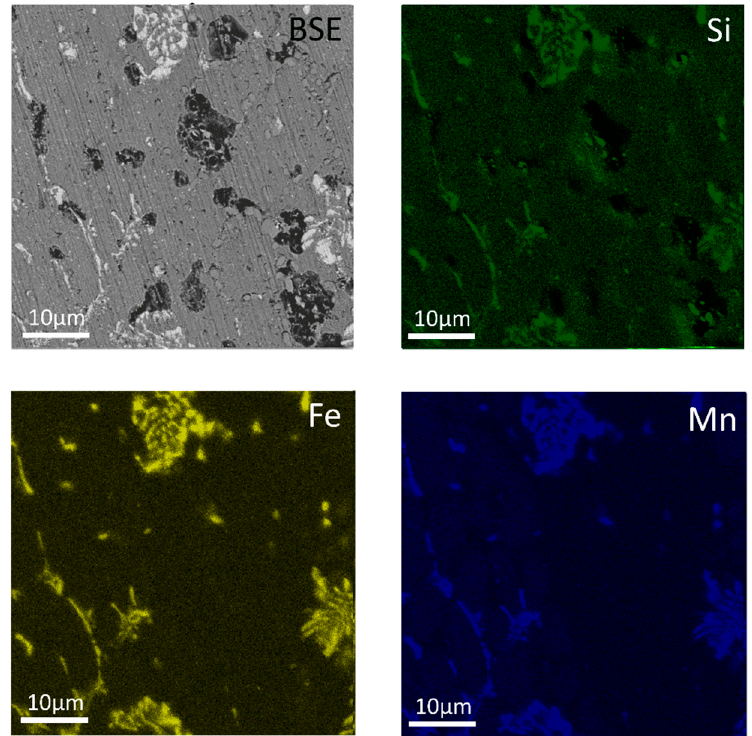
Figure 3. SEM image showing the dissolution of silicon particles and growth of voids (darker areas in the BSE image) in the specimen annealed at 450 °C for 32 h.